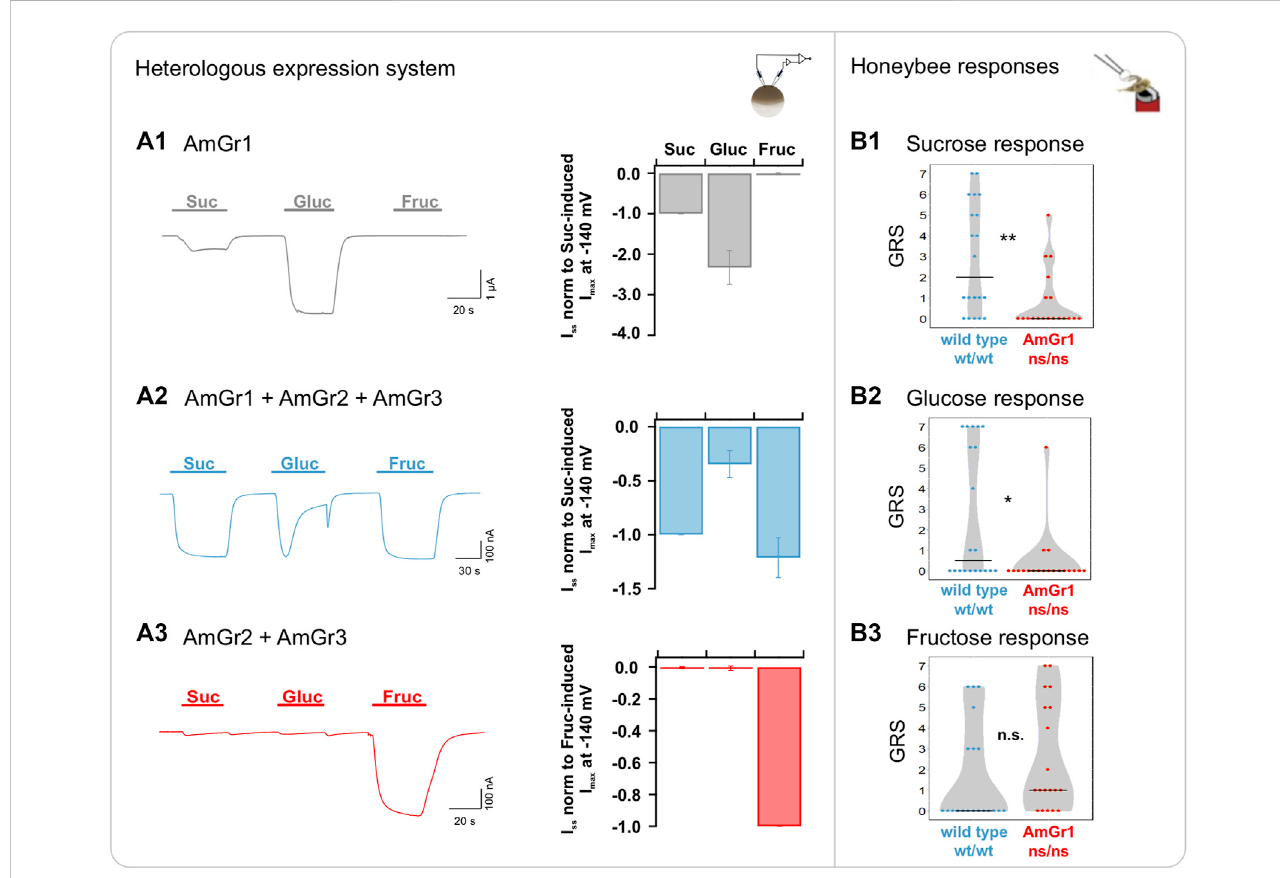
FIGURE 1 Functional analysis of A. mellifera gustatory receptor AmGr1 using a matched heterologous expression system and in vivo comparative approach. (A1 – A3) : two-electrode voltage clamp measurements: Current traces were recorded at a holding potential of − 80 mV in response to perfusion with sucrose (Suc), glucose (Gluc) and fructose (Fruc) in standard solution (left panel). Sugar-induced steady-state currents ( I SS ) were recorded at a membrane potential of − 140 mV(middlepanel). (A1) RepresentativewholeoocytecurrenttraceofAmGr1-expressingoocyte(leftpanel);Quanti fi cationofsugar-induced I SS . Currents were normalized to sucrose-evoked I SS at − 140 mV (mean of n = 16 oocytes ± SD; middle panel). (A2) Control: Inward whole oocyte currents from AmGr1/AmGr2/AmGr3-expressing oocyte (wild-type mimicry; left panel); Quanti fi cation of sugar-induced I SS that were normalized to sucrose-evoked I SS at − 140 mV(meanof n =10oocytes±SD,middlepanel).Thesesamevaluesaredisplayedinall fi guresasconsistentcontrol. (A3) Wholeoocytecurrentsfrom AmGr2/AmGr3 co-expressing oocyte (left panel); Quanti fi cation of sugar-induced I SS . Currents are normalized to the fructose-evoked I SS at − 140 mV (mean of n = 9 oocytes ± SD; middle panel). (B1 – 3) : behavioural evaluation through proboscis extension response (PER, in vivo ). Wild-type (wt/wt, N = 20) and AmGr1 mutant bees (ns/ns; N = 19) were presented a series of sugar concentrations (16%, 20%, 25%, 32%, 40%, 50% and 63% ( w/v ) ; representing .47 M, .58 M, .73 M, .93 M, 1.17 M, 1.46 M and 1.84 M) of all three sugars sucrose (B1) , glucose (B2) and fructose (B3) . The sum of the responses (PERs) towards the concentrationsofoneofthesugarswasrecordedasasugar-speci fi cGRS(gustatoryresponsescore).ThedistributionofallGRSvaluesofallmeasuredbeesis shown as data points and the resulting medians as lines. AmGr1 mutants were less responsive to sucrose when compared with wild-type bees and had signi fi cantly lower GRS (B1) ; Mann-Whitney-U, ns/ns vs. wt/wt, p = .0032, **). Glucose responsiveness in AmGr1 mutants was signi fi cantly lower than that in wild-types (B2) ; Mann-Whitney-U, ns/ns vs. wt/wt, p = .0125, *). Both groups did not differ in fructose GRS (B3) ; Mann-Whitney-U, ns/ns vs. wt/wt, p